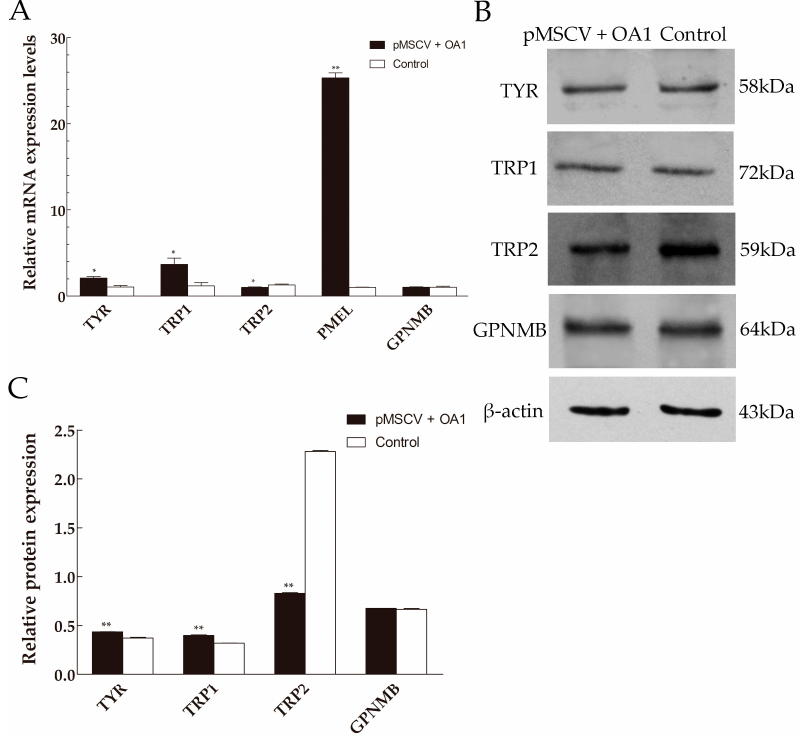
Figure 4. The overexpression of OA1 affects melanosomal proteins in mouse melanocytes. ( A ) The pigmentation-related gene mRNA levels were measured by qRT-PCR; ( B , C ) Western blot of cell lysates probed with primary antibody against the TYR, TRP1, TRP2 and GPNMB. β -actin was used as a protein loading control. Data are shown as the mean ± standard errors ( n = 3 each), * p < 0.05, ** p <